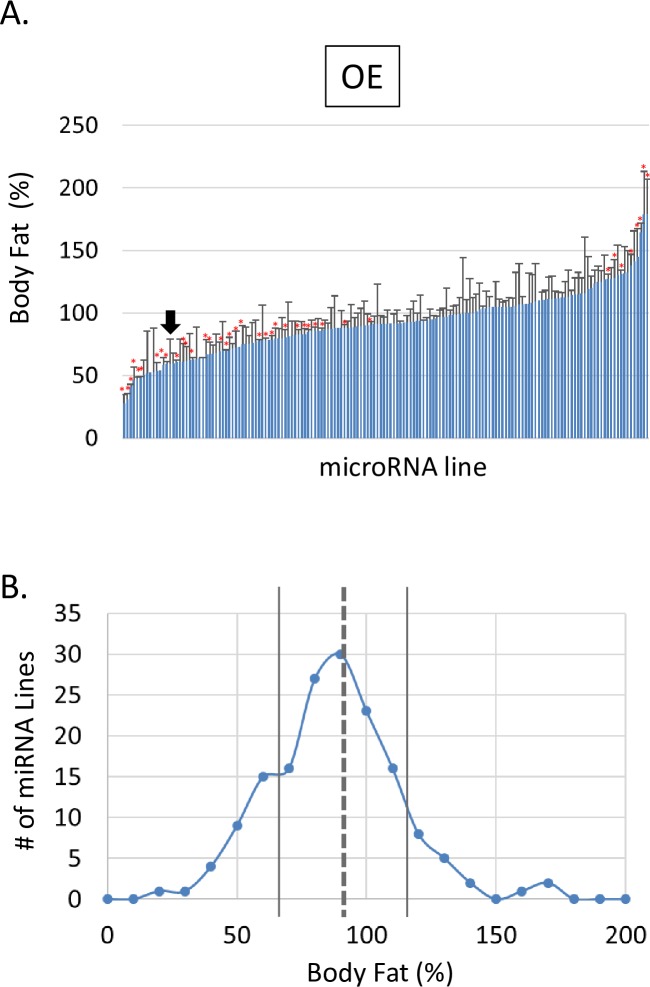
Gain-of-function miRNA lines altered body fat.(A) The amounts of triglyceride (TG) of F1 males from the cross of Act5C-Gal4 and UAS-miRNA were determined using the colorimetric method. Then, the TG content of each miRNA line was compared to that of the W1118 control male; the relative amount of body fat (%) was calculated using the following formula. Relative Body Fat (%) = (TGmiRNA/TGcontrol) X 100; *, P < 0.01 by Student’s t-test. Each bar graph represents a different miRNA line; error bars represent the standard deviation. The black arrow shows miR-969. (B) Each miRNA line was assigned to a bin depending on their male body fat contents. The bins were between 0% and 200% fat contents with 10% increments. The dotted line represents the mean (91.7%); two solid lines (66.5% and 116.9%) denote one standard deviation from the mean.